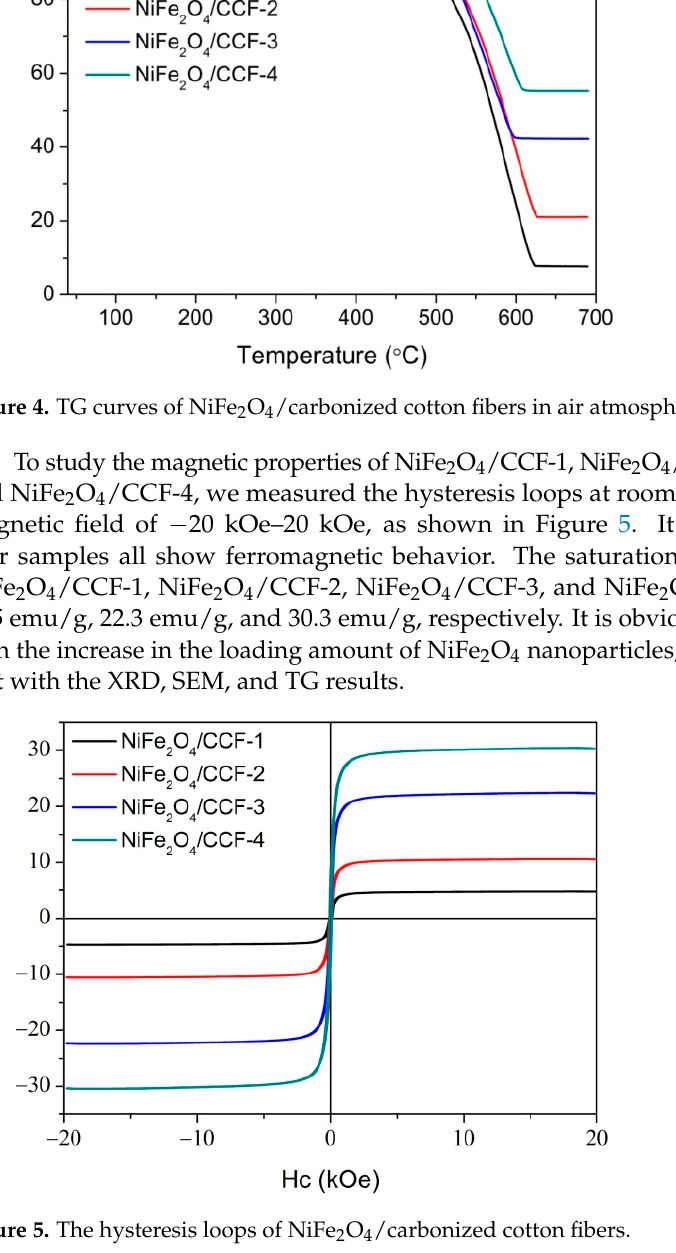
Figure 5. The hysteresis loops of NiFe 2 O 4 /carbonized cotton fibers. From the above analysis, NiFe 2 O 4 /carbonized cotton fibers with different loading amounts of NiFe 2 O 4 nanoparticles were successfully prepared. Generally speaking, elec- tromagnetic parameters are the most direct characterization parameters of the interaction between absorbing materials and electromagnetic waves, so the regulation of electromag- netic parameters is the most direct and effective means of designing absorbing materials. The most important electromagnetic parameters are complex permittivity ( ε r = ε (cid:48) − j ε ”) and complex permeability ( µ r = µ (cid:48) − j µ ”). ε (cid:48) and ε ”, respectively, represent the capacity and